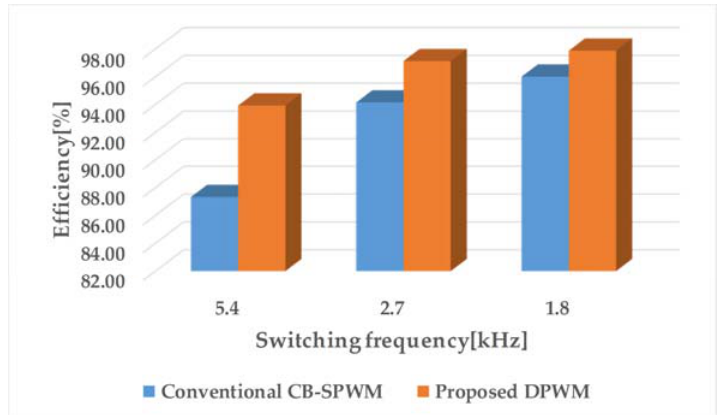
ffi ciency comparisons according to PWM methods and switching Figure 14. Efficiency comparisons according to PWM methods and switching frequencies. Figure 14. E